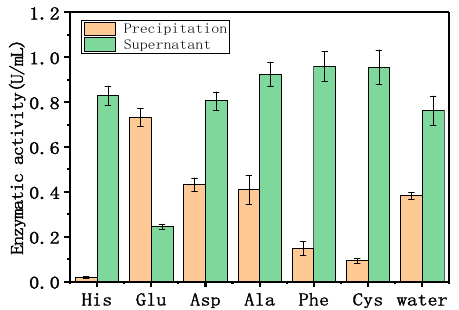
Figure 3. Effect of different amino acids on adsorption.